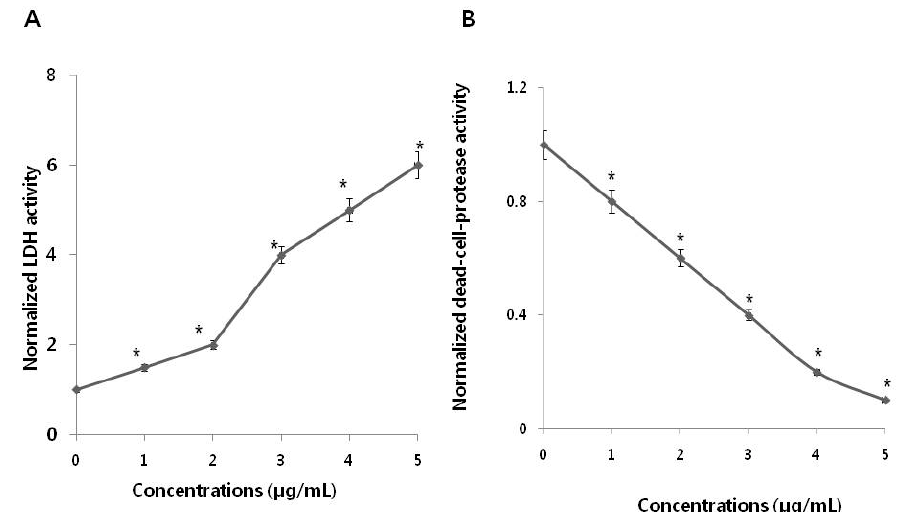
Figure 3. Measurement of lactate dehydrogenase (LDH) leakage and dead-cell protease activity in SKOV3 cells. ( A ) After 24 h of exposure to different PdNPs concentrations, LDH activity was measured at 490 nm, using the LDH cytotoxicity kit. Data were further normalized to LDH activity measured in cell medium to account for damaged/nonviable cells (normalized LDH activity). The PdNPs-pretreated, unexposed control LDH activity is equal to the value of 1 at each time point. These data are representative of three experiments. Error bars represent S.E.M. Asterisks (*) indicate statistically significant increase in LDH activity by treatment with PdNPs (* p < 0.05). ( B ) The levels of dead-cell protease were measured. There was a significant reduction in the number of PdNPs-treated cells compared to the number of untreated cells, as determined by the Student’s t -test (* p < 0.05). Data were further normalized to dead-cell protease measured in cell medium to account for damaged/nonviable cells (normalized dead-cell protease). The PdNPs-pretreated, unexposed control dead-cell protease is equal to the value of 1 at each time point. These data are representative of three experiments. Error bars represent S.E.M. Asterisks (*) indicate statistically significant increase in dead-cell protease activity by treatment with PdNPs (* p < 0.05).